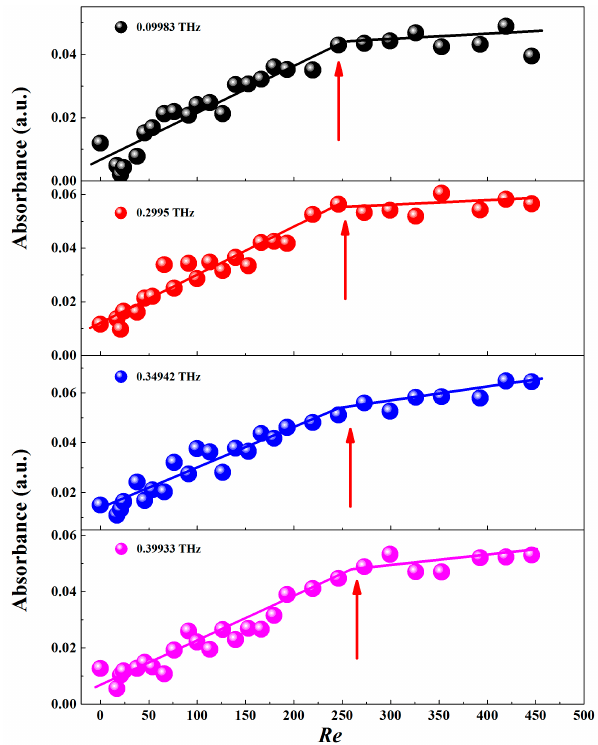
Figure 3. The THz absorbance as a function of Re at various frequencies.